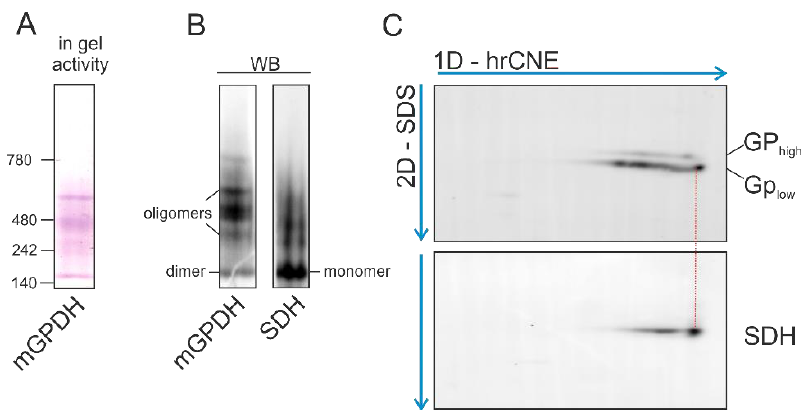
Figure 4. Analysis of mGPDH native forms. HEK293 overexpressing mGPDH (HEK oe, untagged form) were solubilized by digitonin (2 g/g) and samples (40 μg protein) were separated on high-